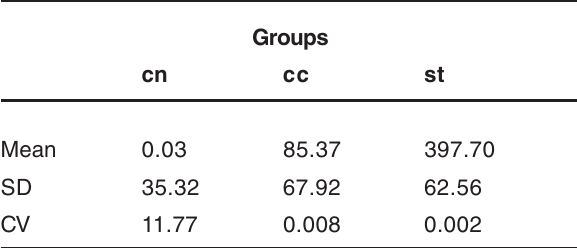
cn = acrylic copings without cervical contact; cc = acrylic copings with cervical contact; st = perforated stock tray.